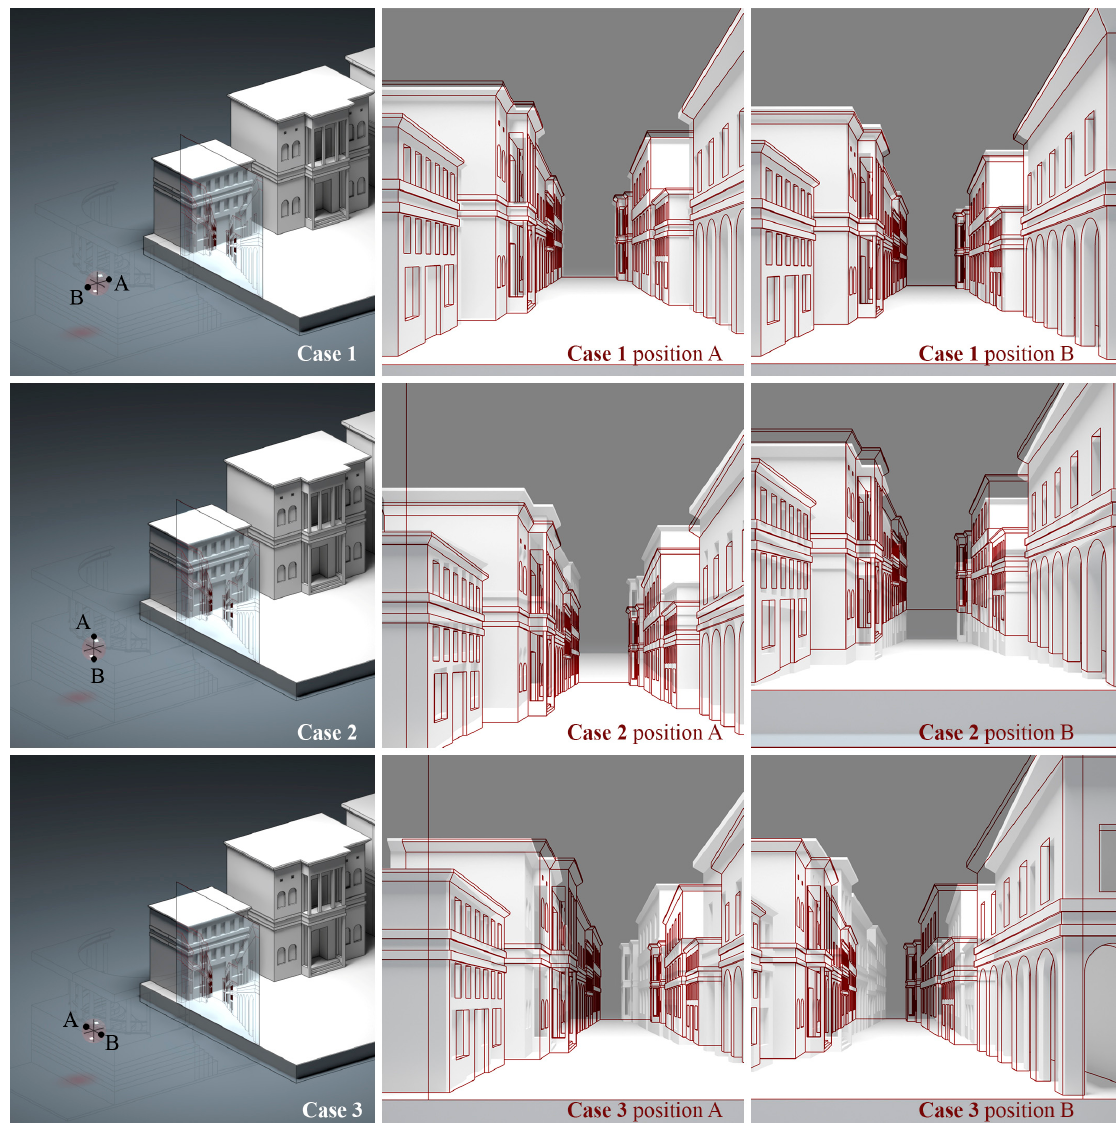
Figure 4. Synoptic picture of the visual perception of the scene seen by an observer placed outside the restricted sight, according to three particular types of motion in case of a linear